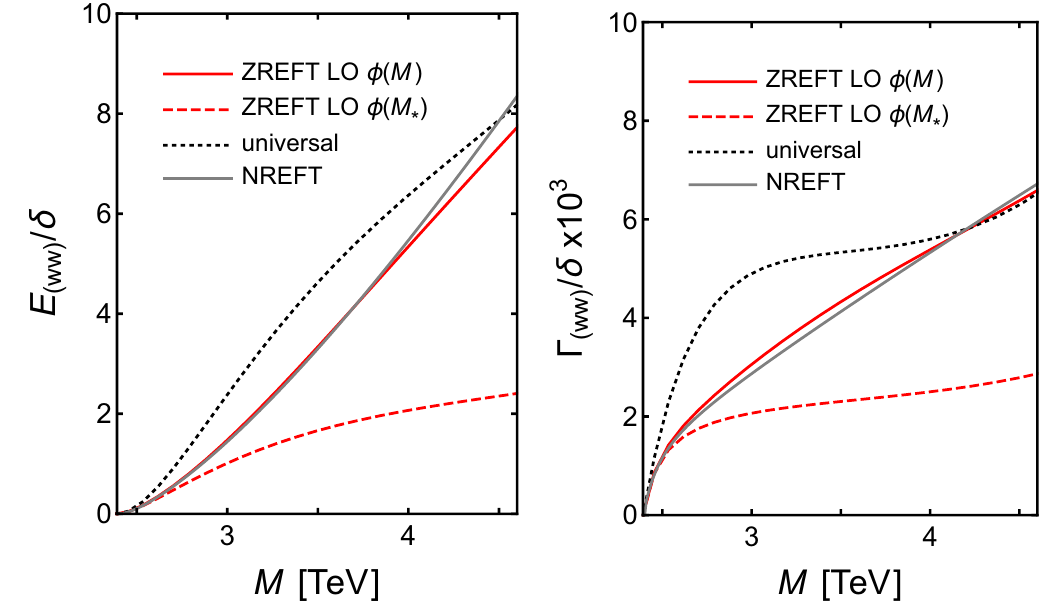
Figure 24 . Binding energy E (left panel) and decay width (cid:0) (right panel) of the wino-pair ( ww ) ( ww ) bound state as functions of the wino mass M : NREFT (thicker grey curves), ZREFT at LO with M -dependent parameter tan (cid:30) ( M ) (solid red curves), and ZREFT at LO with constant parameter tan (cid:30) ( M (cid:3) ) (dashed red curves), and the universal approximations in eqs. (5.39) (dotted